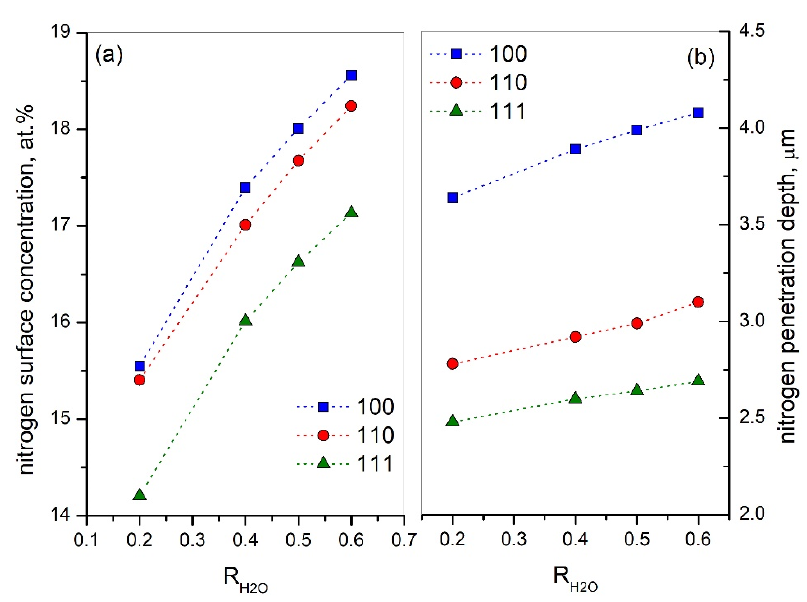
Figure 7. Nitrogen surface concentration ( a ) and nitrogen penetration depth ( b ) as functions of parameter R H2O (reaction rate of water molecule formation) for different crystallite orientations.